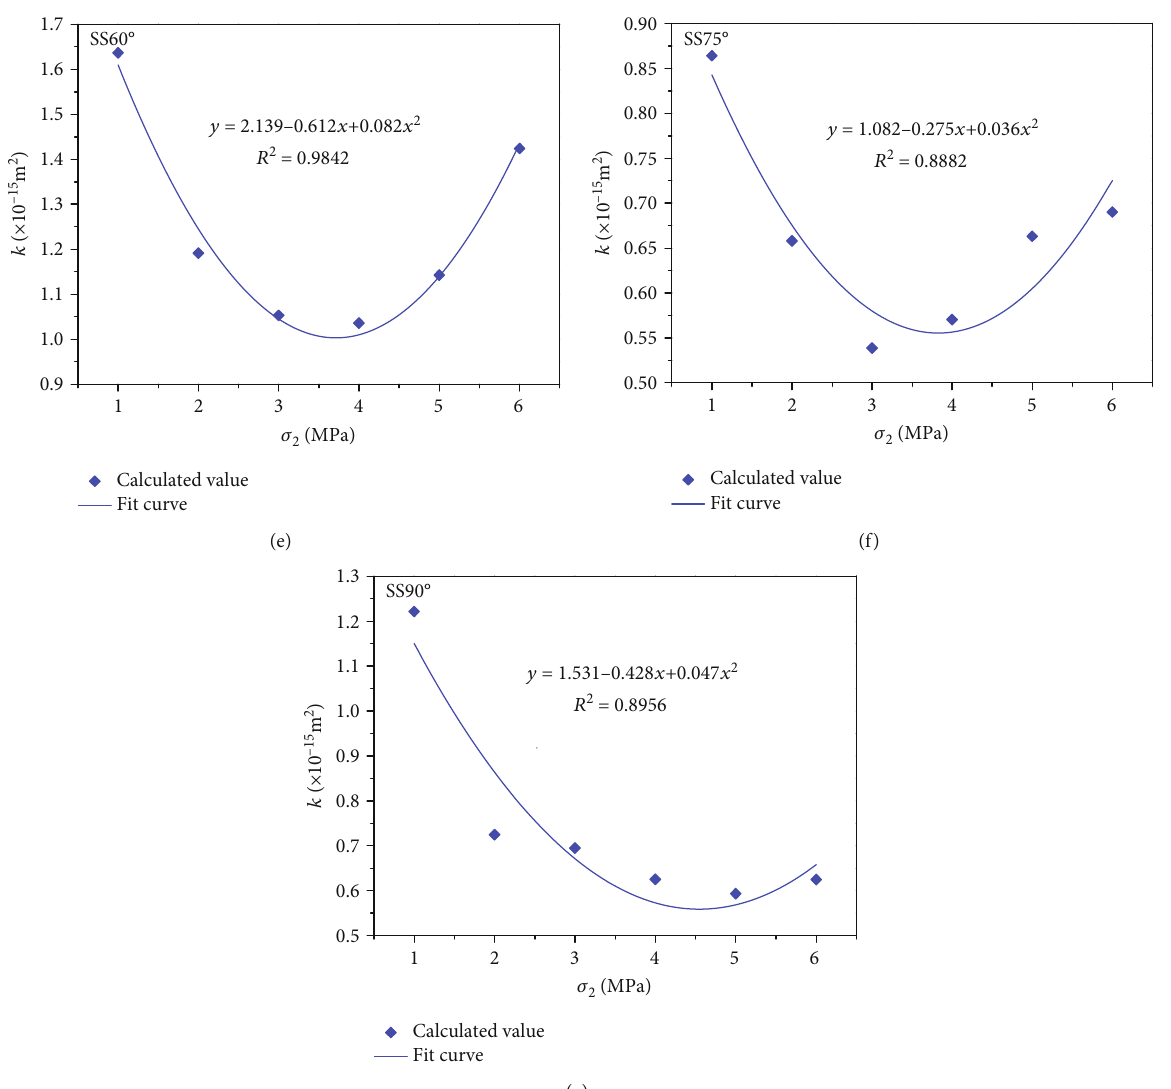
ff erent dip 2 for samples with di